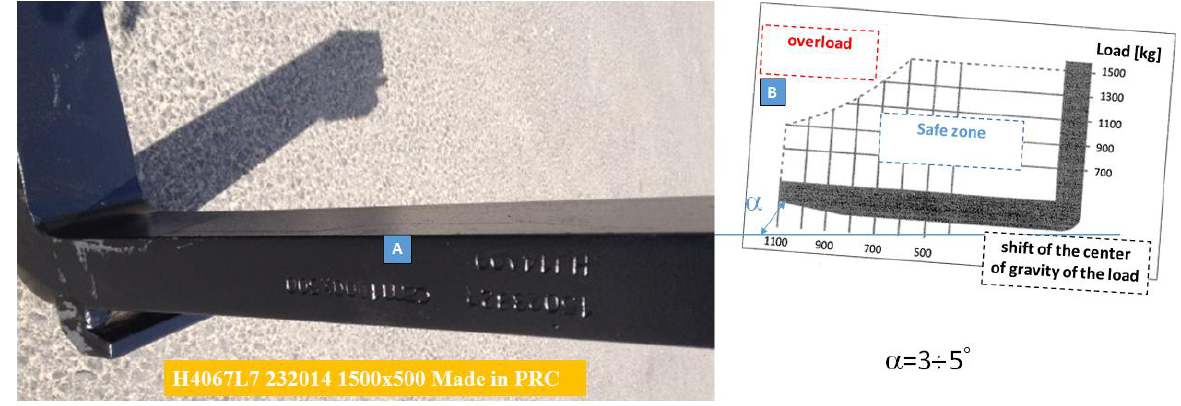
Figure 3. ( A ) Example fork marking: H4067L7 — serial number; 232,014 — production date; 1500 × 500 — fork length and lifting capacity; made in China; ( B ) — safe pallet location on forks.